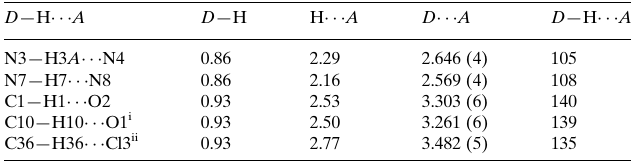
Hydrogen-bond geometry (A ˚ , (cid:3)